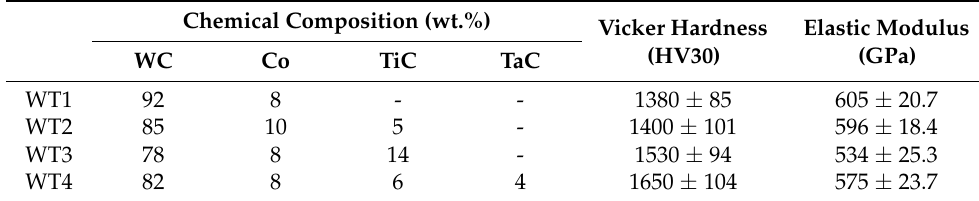
Table 1. Chemical composition and properties of WT1, WT2, WT3 and WT4 substrates. Chemical Composition